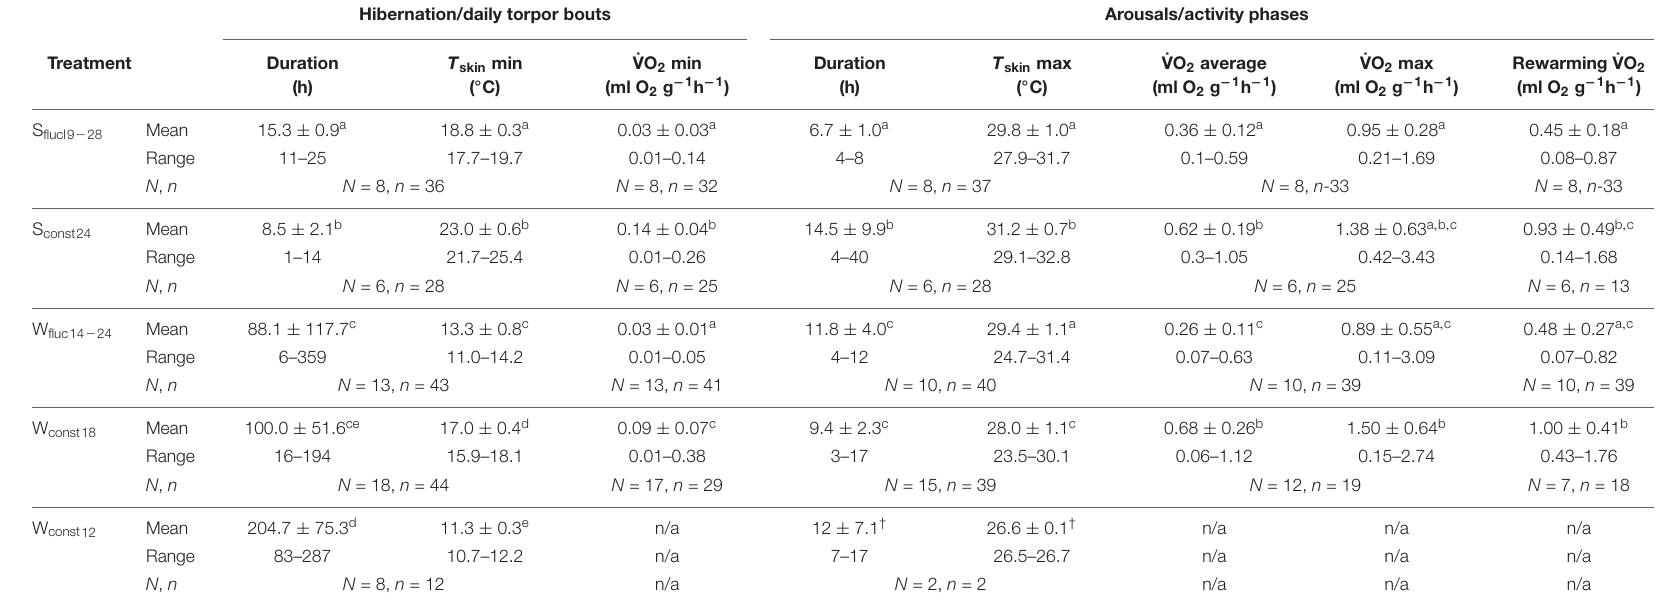
TABLE 1 | Torpor and arousal/activity phase characteristics of Echinops telfairi for all five experimental treatments. Hibernation/daily torpor